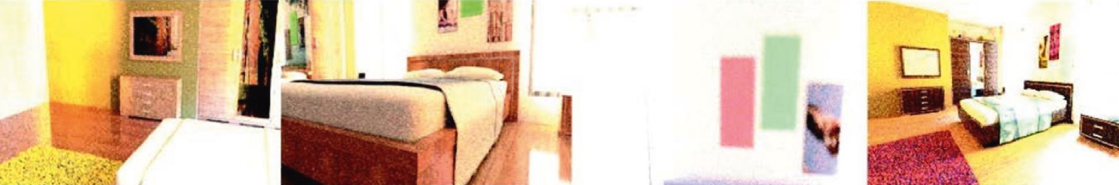
Figure 5: A partial example of the training data set.